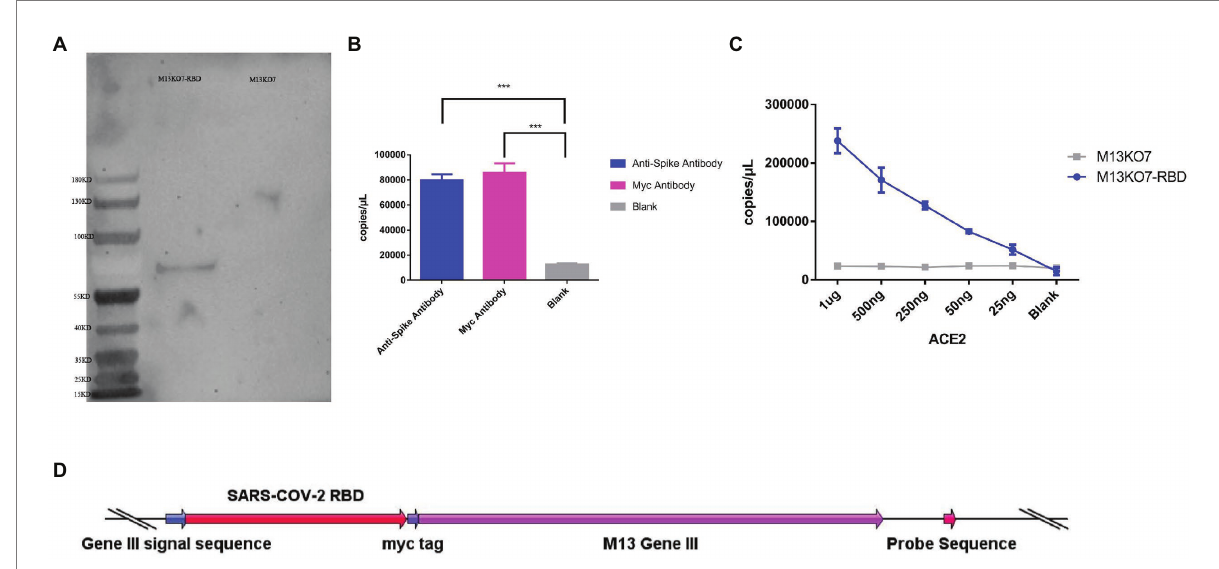
FIGURE 2 Construction and synthesis of the recombinant phage. (A) Detection of the expression of the myc tag on wild-type M13KO7 and the recombinant phage by Western blotting. (B) The enrichment of the recombinant phage among the antibodies targeted to the spike protein of SARS-CoV-2 and myc tag; *** p < 0.001. (C) The enrichment of the RBD-displaying phage and the wild-type M13KO7 by ACE2. (D) The phage vectors used to express the polyvalent display phage. The values shown are the average of three independent experiments and their standard